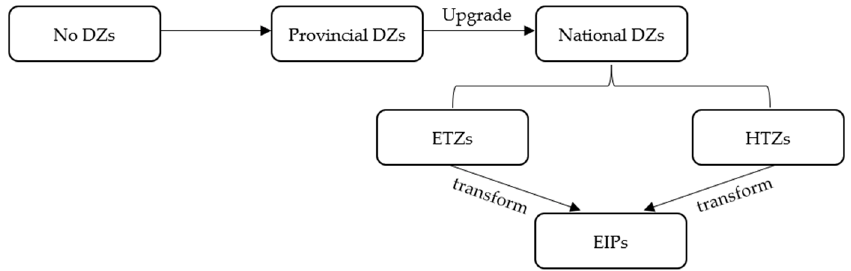
Figure 2. The process of upgrading and transforming DZs into EIPs.